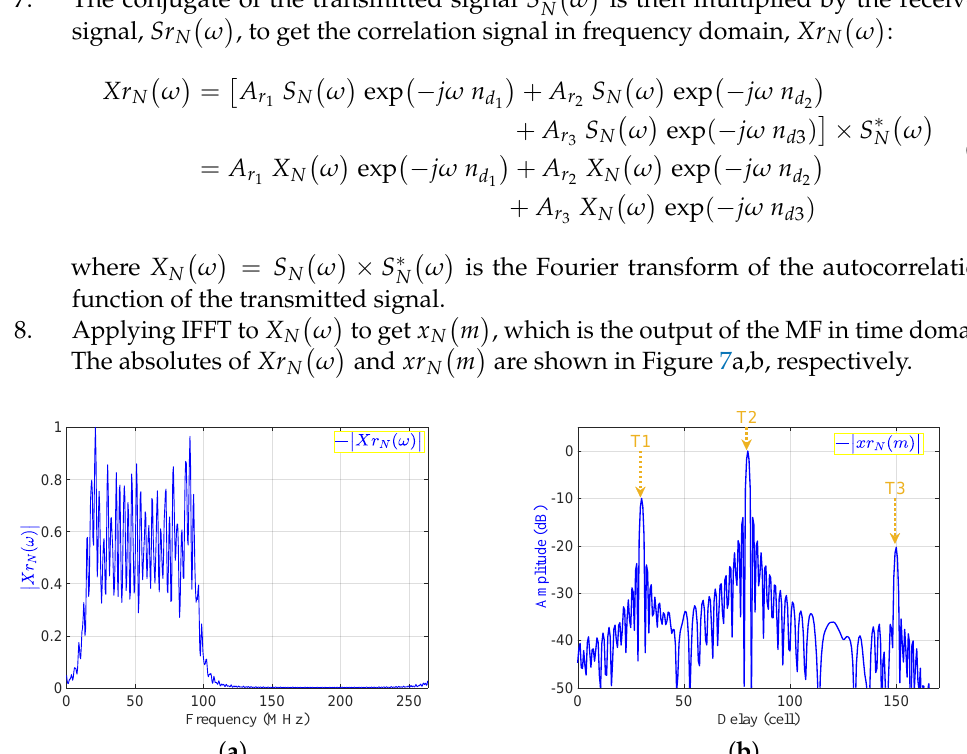
Figure 7. The matched filter output in frequency and time domains: ( a ) 9. The proposed frequency response of the SRF, H SRF